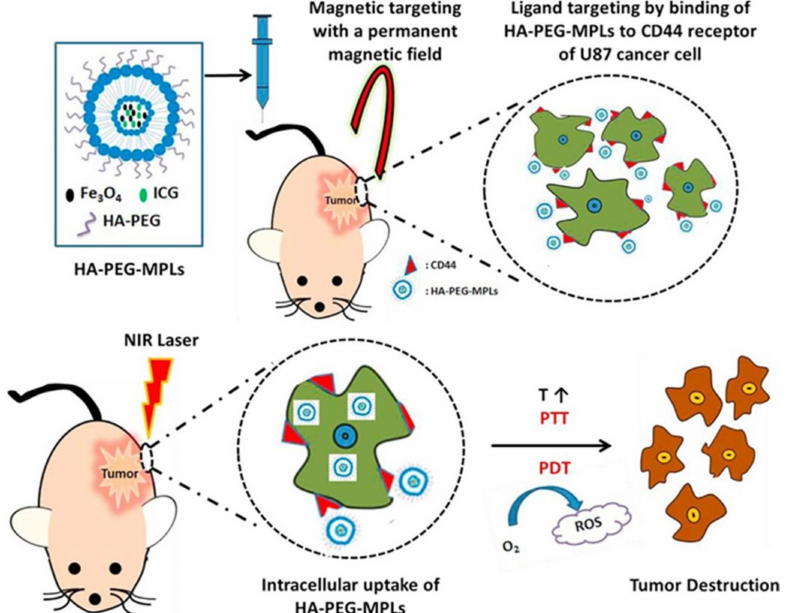
Figure 5. Schematic illustration of HA-PEG coated magnetic/photoresponsive liposomes for com- bined photothermal/photodynamic cancer therapy. ICG, Indocyanin green PS; HA-PEG, hyaluronic acid-polyethylene glycol; MPLs, magnetic/photoresponsive liposomes; PTT, photothermal therapy; ROS, reactive oxygen species. Reprinted with permission from ref. [87]. 2019 Meng et